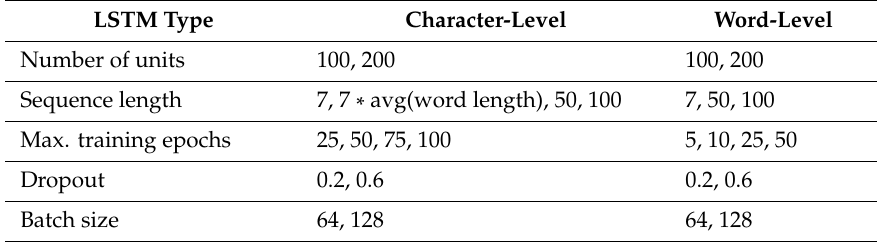
Figure 1. RNN network architectural layers forming the word-level ( left ) and character-level ( right ) text generation models. Table 2. List of all of the parameters tested for the two types of LSTM text generation models.